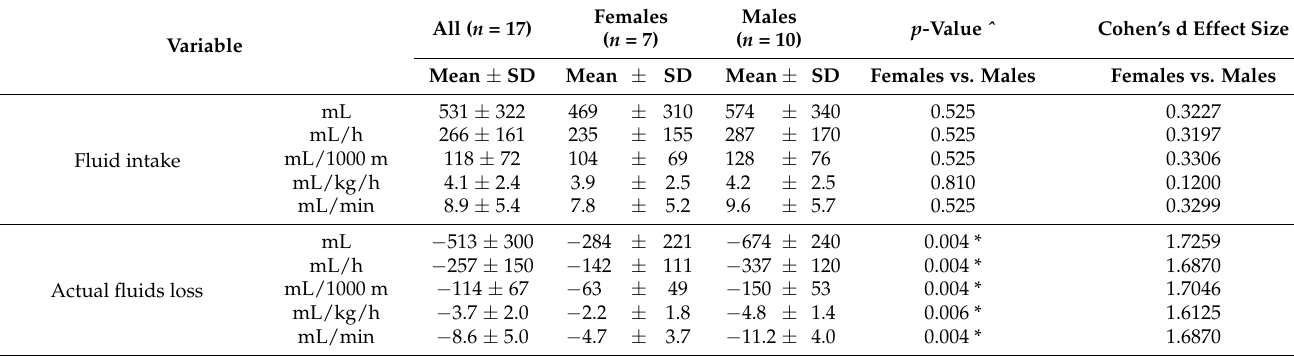
Table 1. Fluid intake and actual fluids loss in the whole group, female and male.